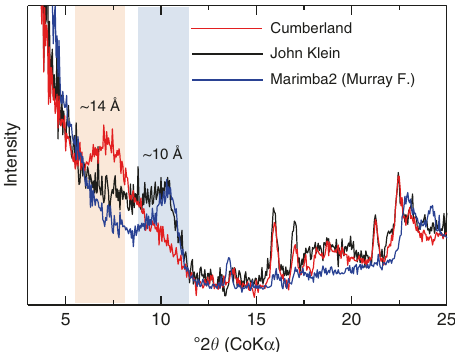
Fig. 2 Basal spacings of smectite from John Klein (black) and Cumberland (red), compared with Marimba2 (blue) in Murray formation, obtained by Curiosity ’ s CheMin. The 001 re fl ection peaks at 10 Å (blueish background) and 14 Å (orangish background) are mainly due to Na + and Mg 2 + in the interlayers, respectively. Yellowknife Bay smectites contain less Na + and more Mg 2 + in the interlayers than